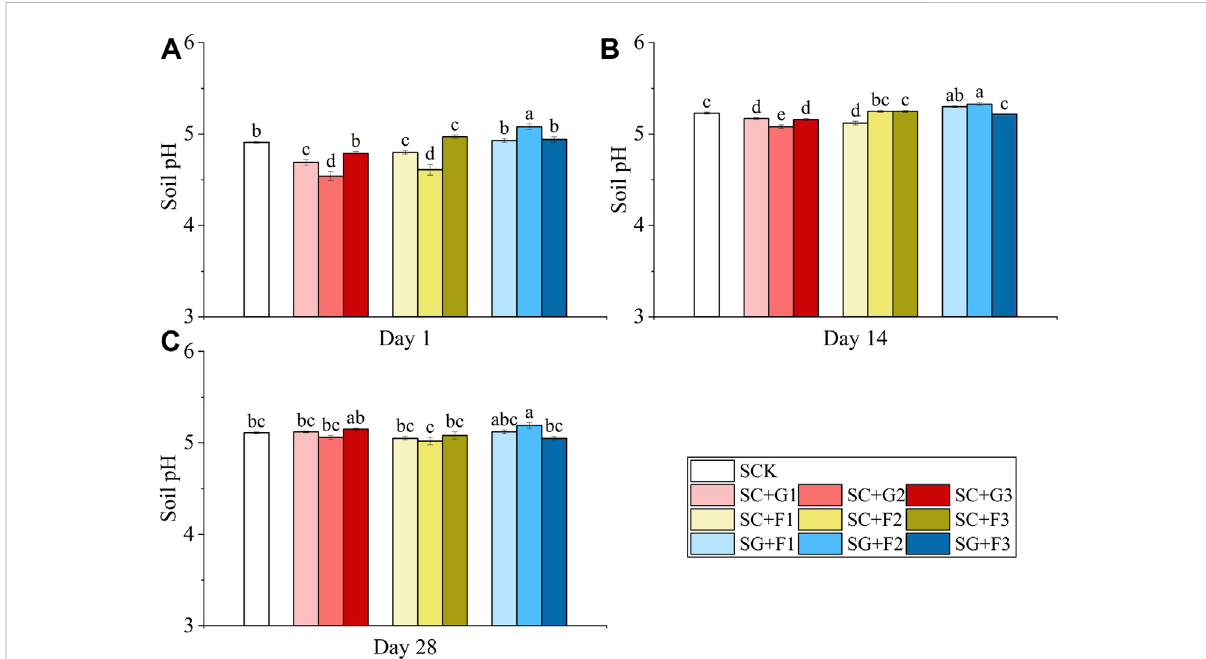
FIGURE 3 Changes in soilpH under thecombined treatment of citric acid, Gly and fructose on days 1 (A) , 14 (B) , and 28 (C) . The combination ofcitric acid +Gly:SC+G1,SC+G2,SC+G3;thecombinationofcitricacid+fructose:SC+F1,SC+F2,SC+F3;thecombinationofGly+fructose:SG+F1,SG + F2, SG + F3 (Different letters in each sampling time point show signi fi cant differences, p < 0.05).